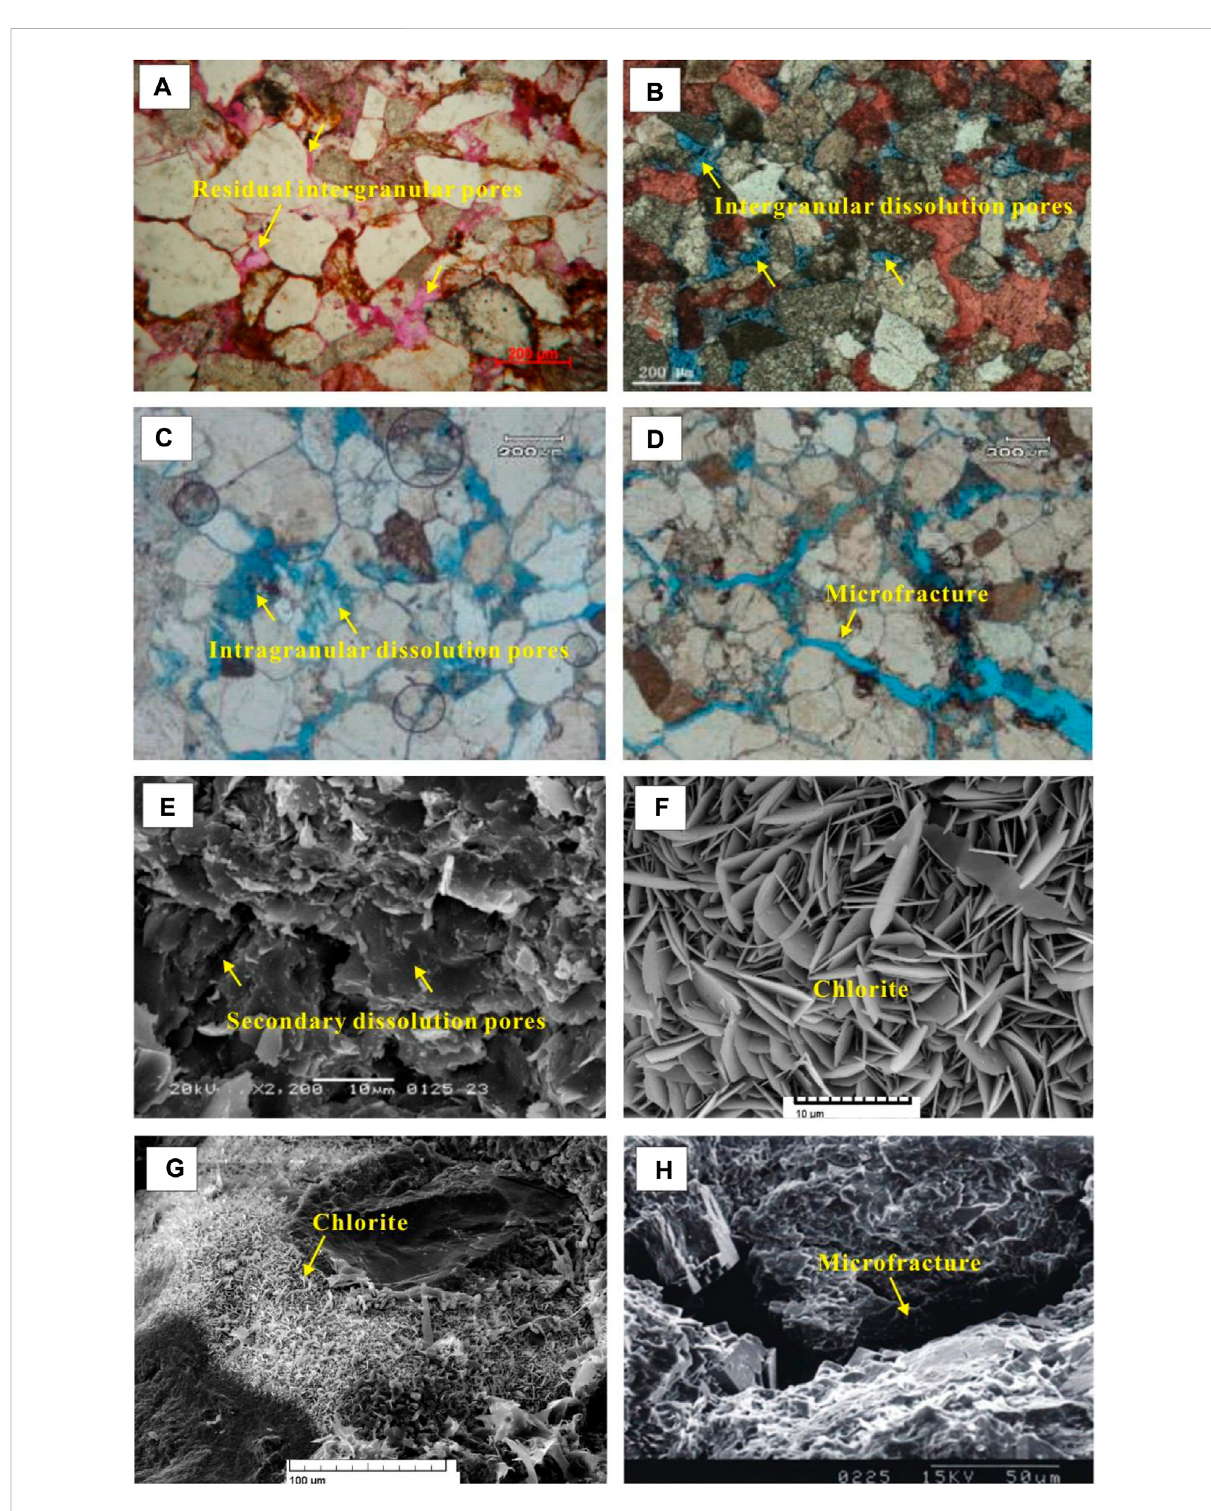
FIGURE 9 Microscopic characteristics of sandstone reservoirs in Xujiahe Formation. (A) Well Yu 1, 4,379.55 m, residual intergranular pores and intergranular dissolved pores; (B) Well Jinhua 3, 3,298.00 m, intergranular dissolved pores; (C) Well W6, 1,127.80 m, intergranular pores and intragranular dissolved pores; (D) Well Ma 14, 1,317.10 m, microfractures; (E) Well Qiulin 7, 3298 m, secondary dissolved pores; (F) Well Jiao 41, 3,076.0 m, needle-like and leaf-like chlorite; (G) Well Baoqian 001 – 16, 1,585.5 m, coniferous chlorite; (H) Well Guan 2, 3,665.85 m, open microfractures with dissolved